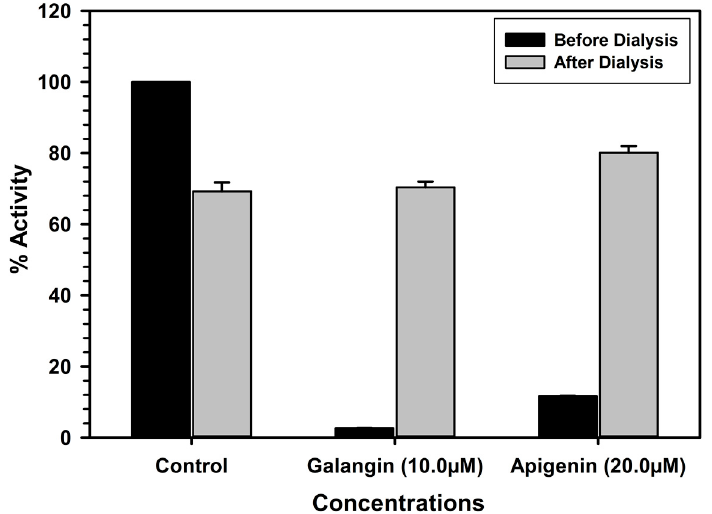
Figure 6. Analysis of nature of binding of galangin and apigenin with recombinant human MAO- A by recovery of catalytic activity of the enzyme after dialysis dissociation. Each bar shows mean ± S.D. of triplicate values.